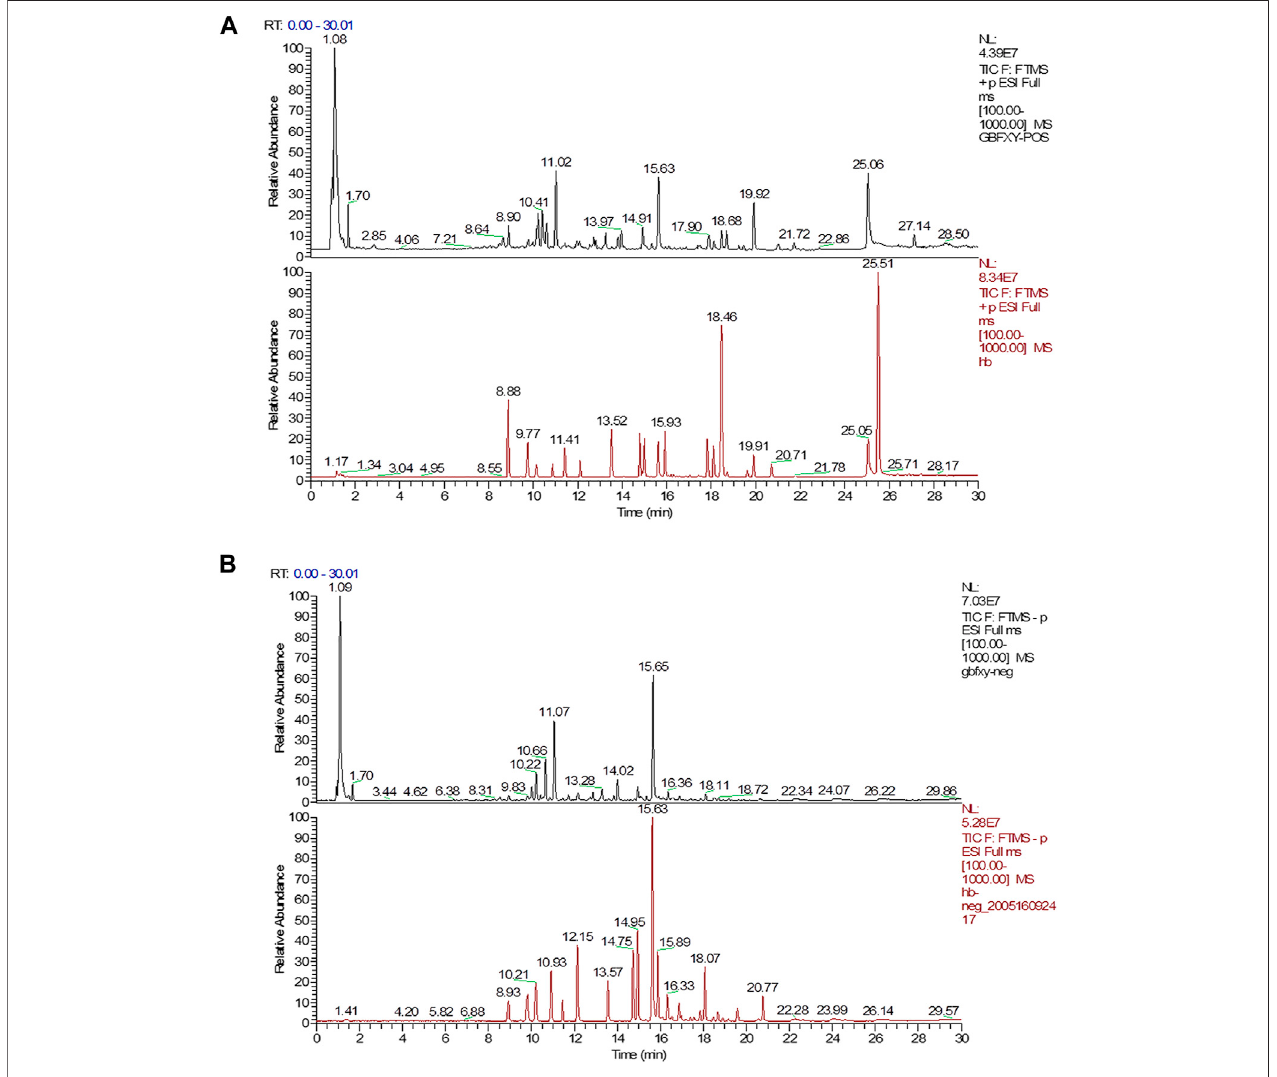
FIGURE1| UPLCchromatograms analysisofGBFXDwiththerepresentativeactiveingredients. (A) Thetotalchromatogramsinpositiveionmode(black,GBFXD; Red, standards); (B) The total chromatograms in negative ion mode (black, GBFXD; Red, standards).